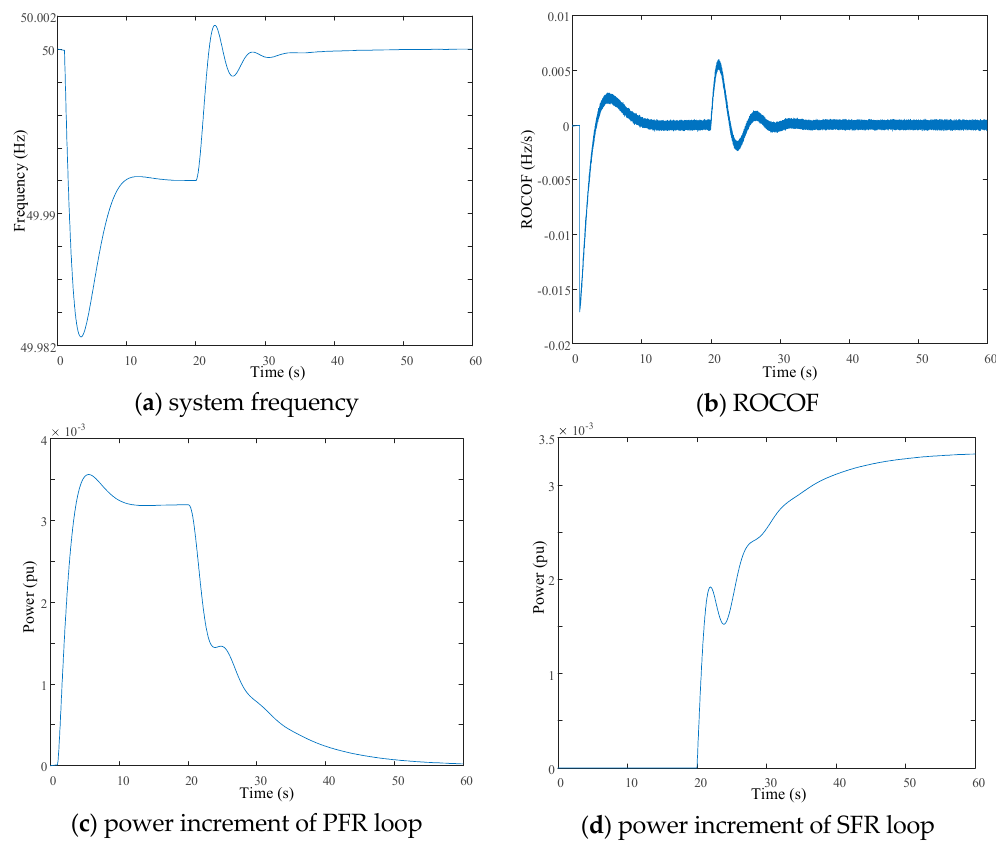
Figure 9. Simulation of load forecast gap in TFR.